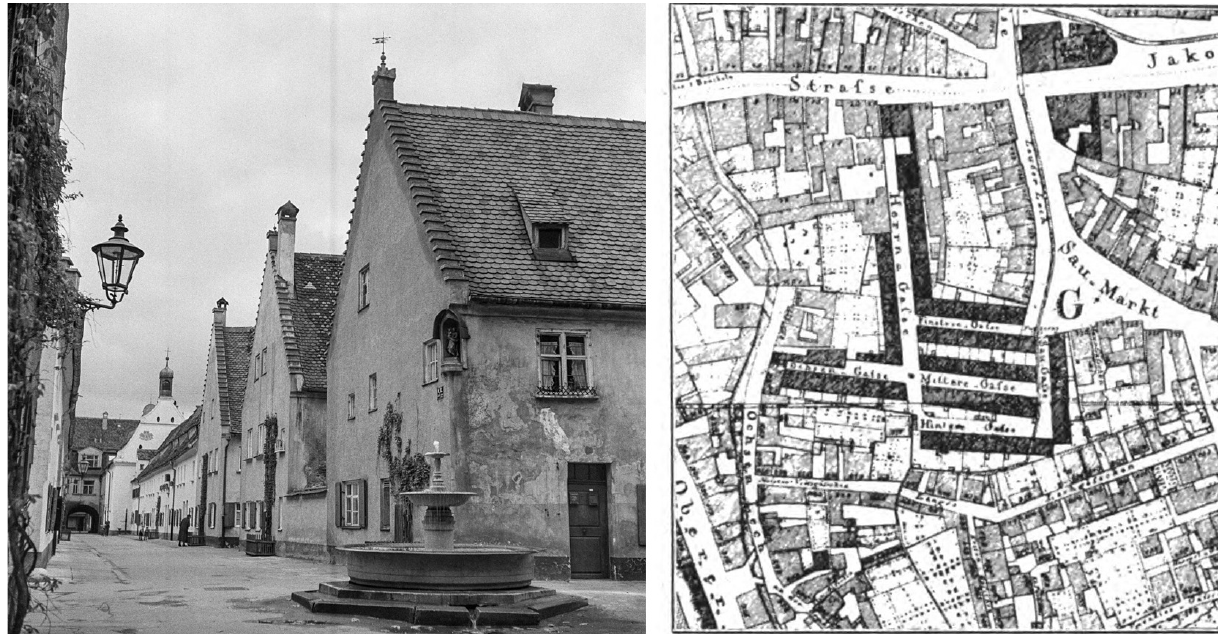
Figure 5. Left: Photograph depicting a street in the Fuggerei. Right: Map highlighting the plan of the Fuggerei. Sources: Aufsberg (1939, © Bildarchiv Foto Marburg/Lala Aufsberg) and Kuhn (1921, p. 105). Urban Planning, 2022, Volume 7, Issue 1, Pages